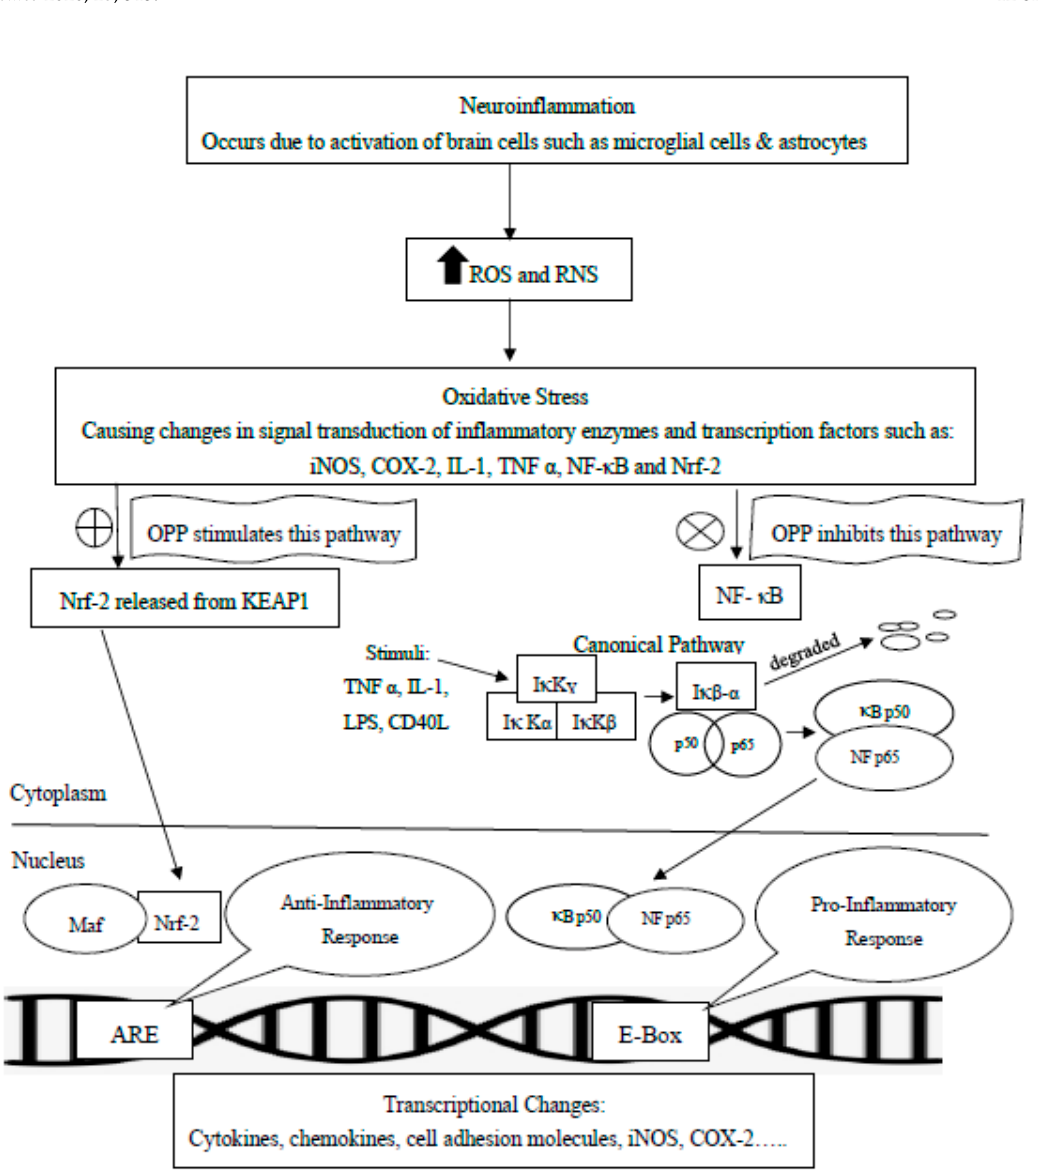
Figure 2. Canonical Pathway of NF- κ B which represents the pro-inflammatory response, and Keap-Nrf2-ARE Pathway which represents anti-inflammatory response. Both pathways may potentially a ff ected by OPP for attenuating neuroinflammation. ⊕ : activate or stimulate; ⊗ : inhibit; ARE: antioxidant response element; CD40L: CD 40 ligand; COX-2: cyclooxygenase-2; E-Box: Enhancer Box; iNOS: inducible nitric oxide synthase; IL-1: Interleukin-1; I κ K α , β